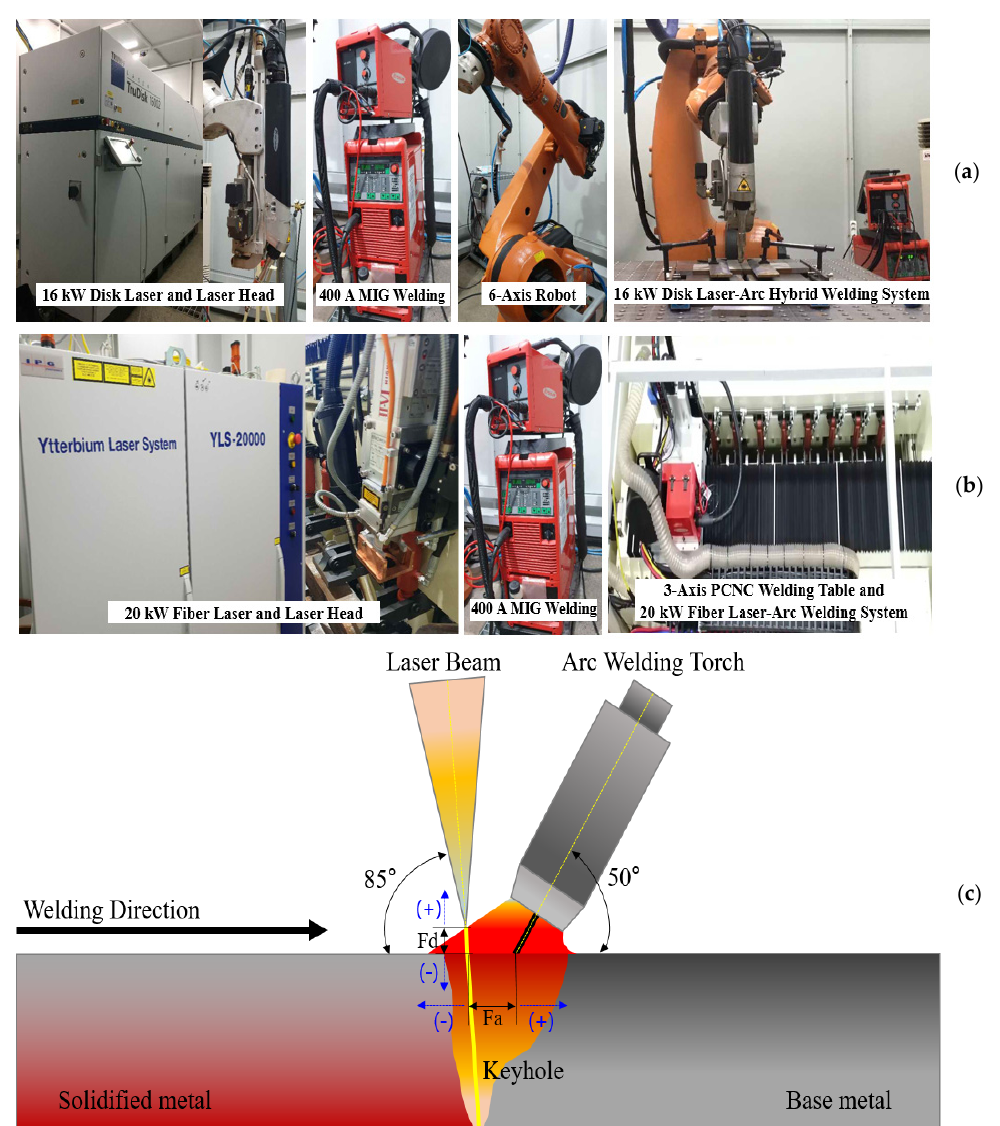
Figure 1. Specifications of the test specimen and the experimental setup of the test specimen. ( a ) Dimension of the test specimen, ( b ) experimental setup of the test specimen.